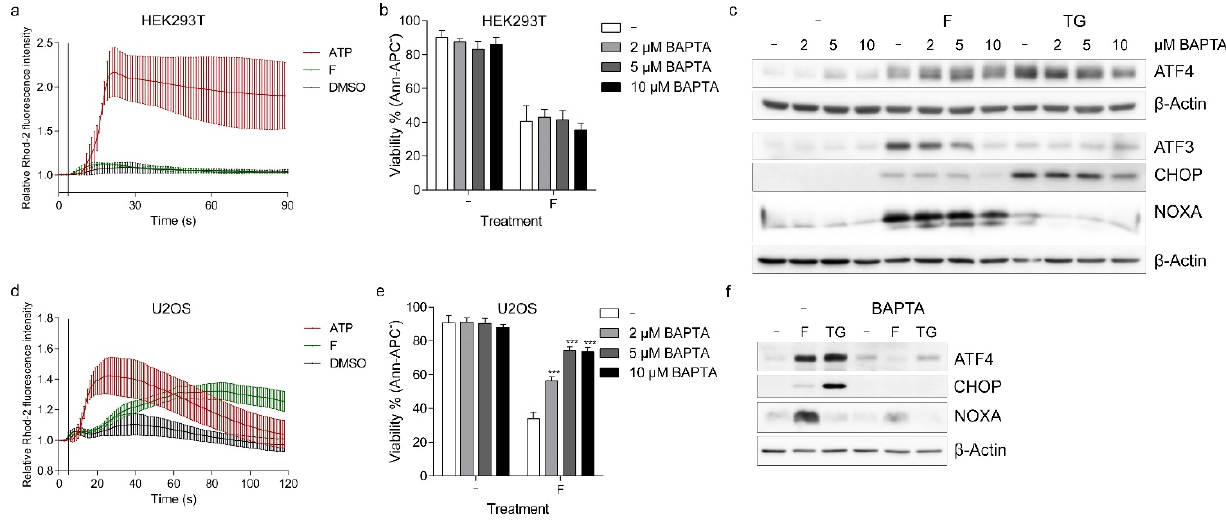
Figure 6. Fluorizoline causes calcium mobilization in U2OS cells. ( a ) HEK293T and d U2OS cells were loaded with 5 µ M Rhod-2 30 min prior to the start of the experiment. Live-cell images were acquired at intervals of 1 s for 2 min starting 5 s prior to treatment. HEK293T and U2OS cells were treated either with 100 μ M ATP as a positive control, 15 and 20 μ M fluorizoline, respectively, or with the corresponding concentration of vehicle (DMSO). ( b , c ) HEK293T and ( e , f ) U2OS cells were pre-treated with the indicated doses or ( f ) with 10 μ M BAPTA for 1 h and then treated either with 15 or 20 μ M fluorizoline, respectively, or with 20 μ M thapsigargin (TG) for ( c , f ) 4 h or ( b , e ) 24 h. ( b , e ) Viability was measured by flow cytometry, and it is expressed as the mean ± SEM of the percentage of non-apoptotic cells (annexin V-negative). *** p < 0.001. BAPTA vs.-( a n ≥ 3; b n = 3; d n = 3; e n ≥ 3). ( c , f ) Protein levels were analyzed by Western blot. β -actin was used as a loading control. These are representative images of at least three independent experiments.